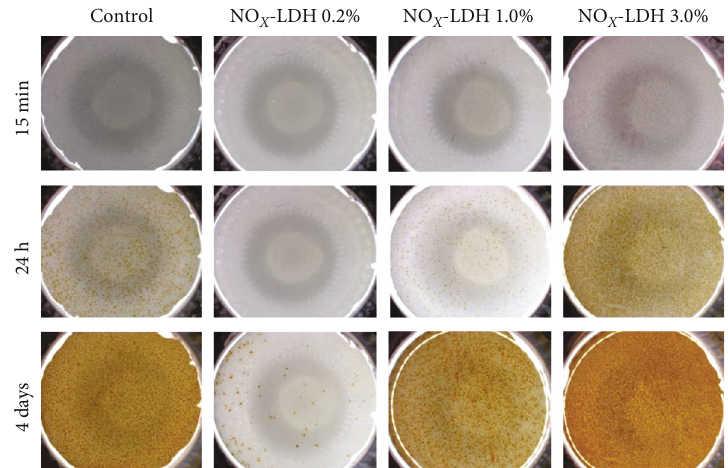
Figure 18: Physical aspect of metallic surfaces coated using primer with and without NO